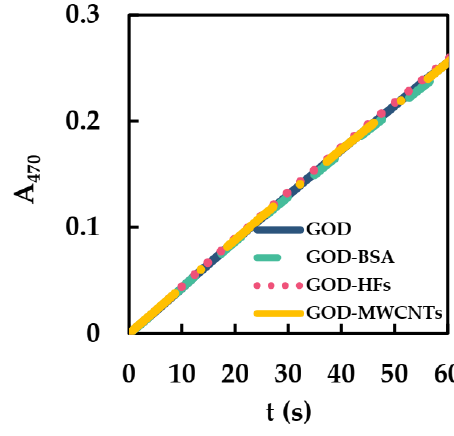
Figure 3. ICRR of GOD (1.20 × 10 − 5 mM), MWCNTs/GOD (1.34 × 10 − 3 mg · mL − 1 and 1.20 × 10 − 5 mM), HFs/GOD (1.34 × 10 − 3 mg · mL − 1 and 1.20 × 10 − 5 mM), and BSA/GOD (8.00 × 10 − 6 mM and 1.20 × 10 − 5 mM) in 50 mM phosphate-buffered solution (pH 6, 25 ◦ C) containing HRP (2.50 × 10 − 5 mM), guaiacol (3 mM), and Glu (50